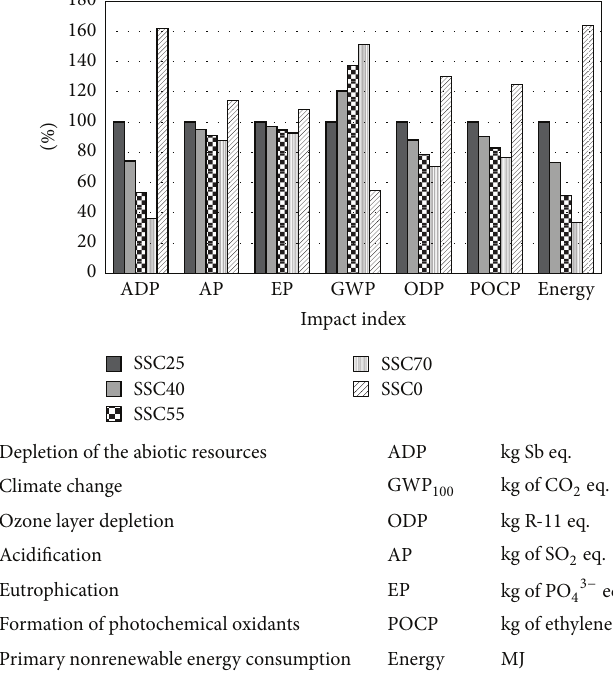
Figure 2: LCA of growing media compared: analysis